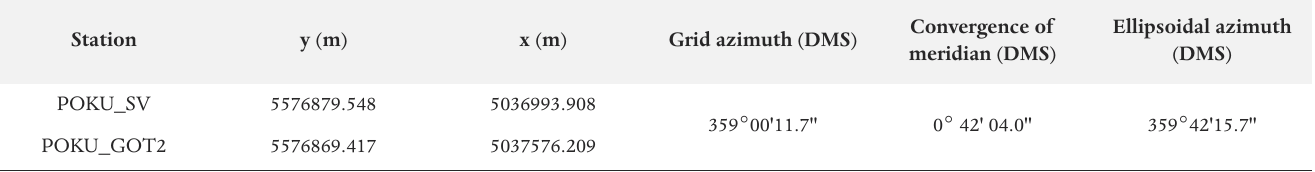
Table 1. Plane coordinates (y,x) and the ellipsoidal azimuth of the POKU_SV repeat station and the reference mark POKU_GOT2 (y-north direction, x-east